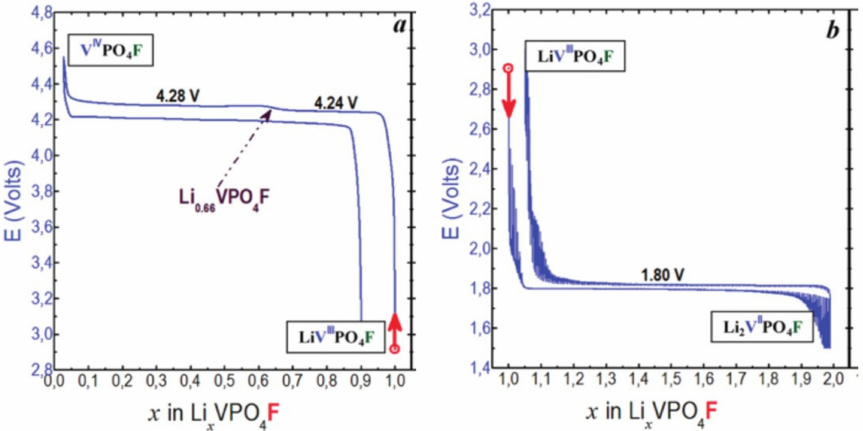
Figure 12. Voltage profile of Li x VPO 4 F cycled between 3.0–4.6 V vs. Li + /Li ( left ) and between 3.0 and 1.5 V vs Li + /Li in GITT mode ( right ) adapted from ref. [14]. Reproduced with permission from Ateba Mba et al., Chemistry of Materials; published by American Chemical Society,